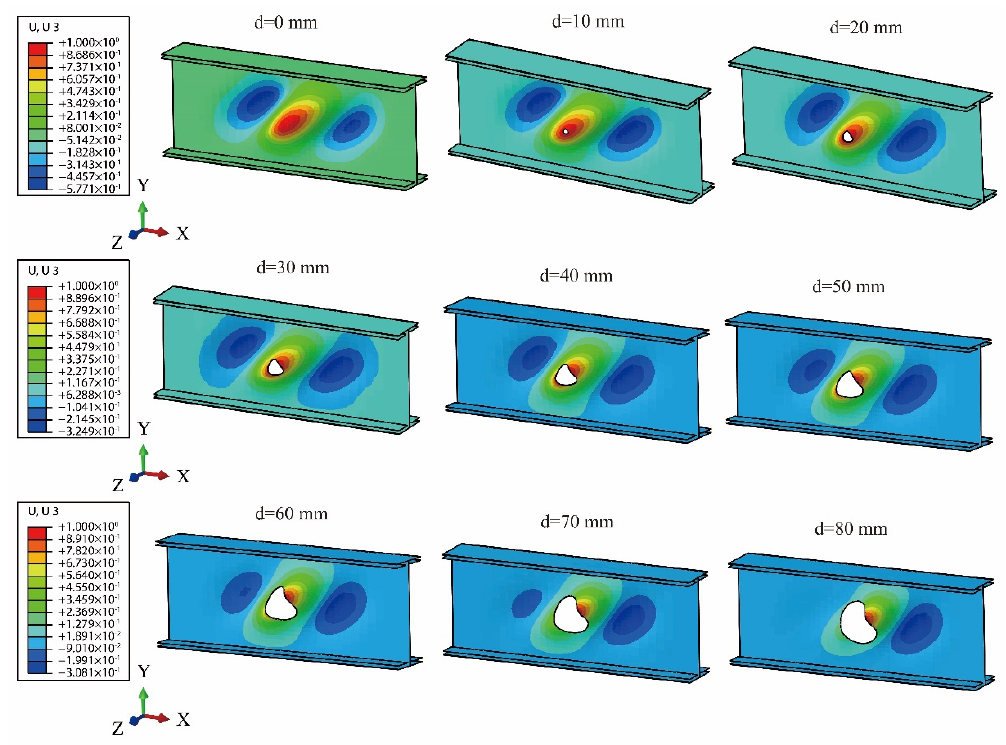
Figure 36. The first buckling mode of the FE models with the centered open-holes of different diameters.